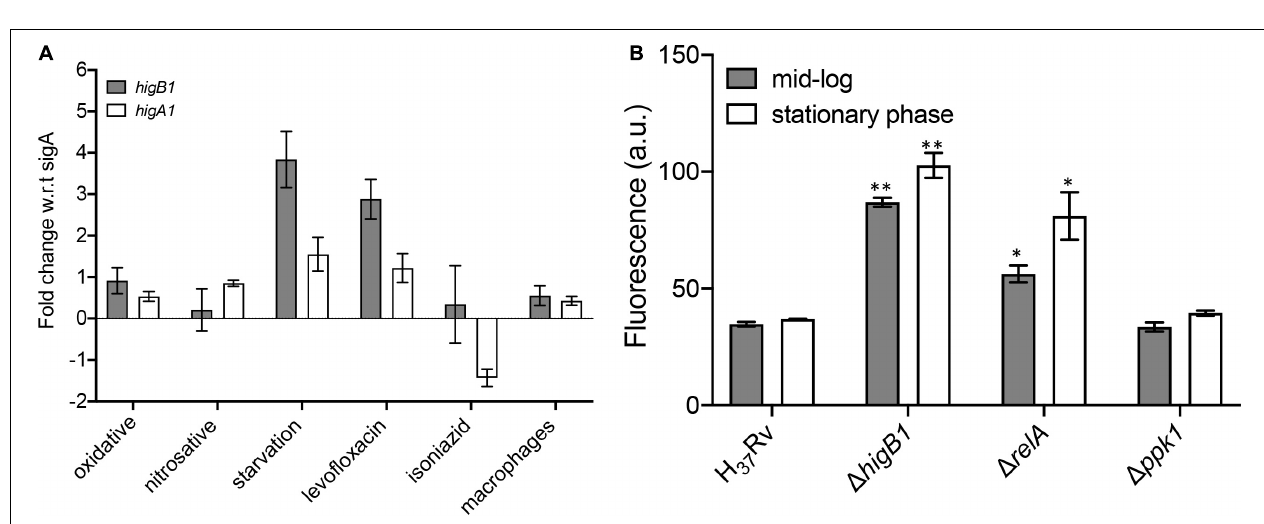
FIGURE 3 | qPCR studies to determine the relative levels of higB 1 and higA 1 in different stress conditions. (A) The transcript levels of higB 1 and higA 1 were determined using gene specific primers as described in section “Materials and Methods.” The data obtained was normalized to the levels of sigA , housekeeping gene and shown as mean ± SE obtained from three independent experiments. (B) Promoter activity assays. The promoter activity was measured in various strains at different stages of growth as described in section “Materials and Methods.” The data shown in mean ± SE of promoter activity obtained in various strains. Statistically significant differences were observed for the indicated groups, ∗ P < 0.05, ∗∗ P < 0.01.